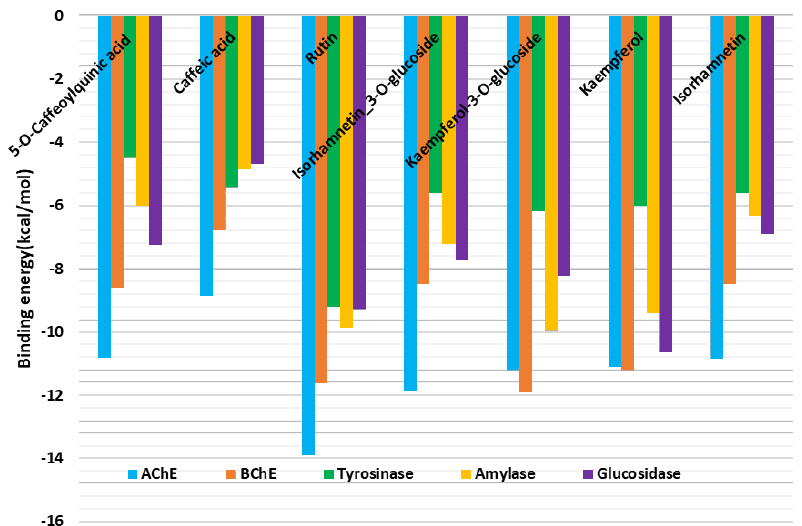
Figure 2. Binding energy (docking) scores of the bioactive compounds from the tested extracts against each of the target enzymes.